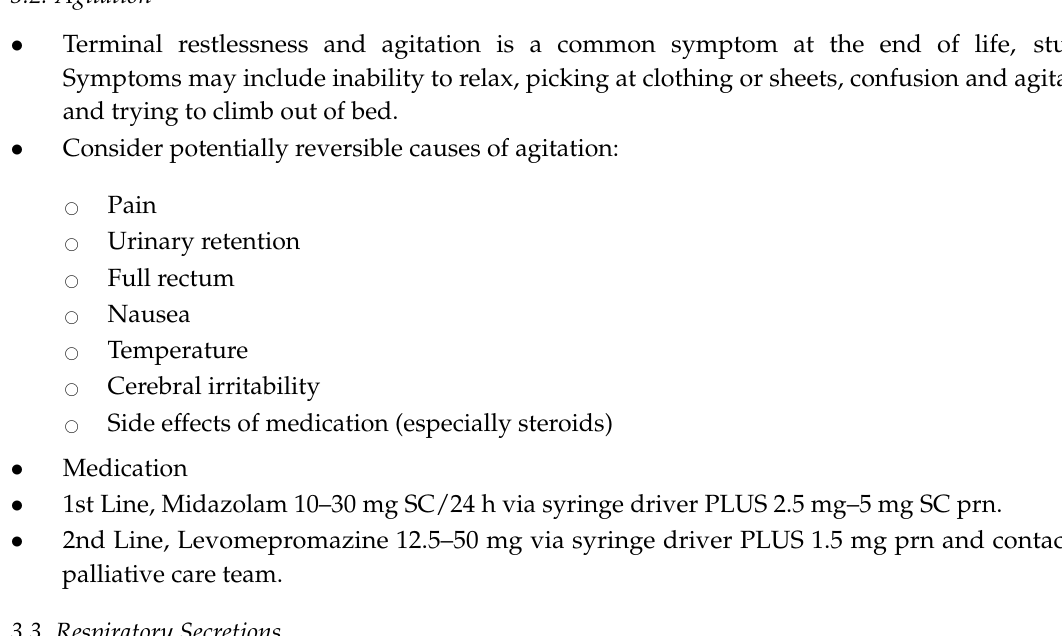
Management: Table 4 below recommends medications to manage the respiratory secretions in those patients approaching the end of life: